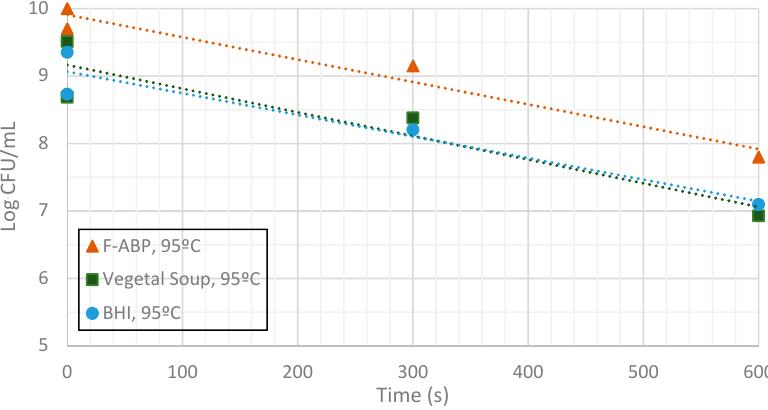
Figure 9. Measurement of CFUs in the substrates indicated at a target temperature of 95 °C. Sensors 2017 , 17 , 1309